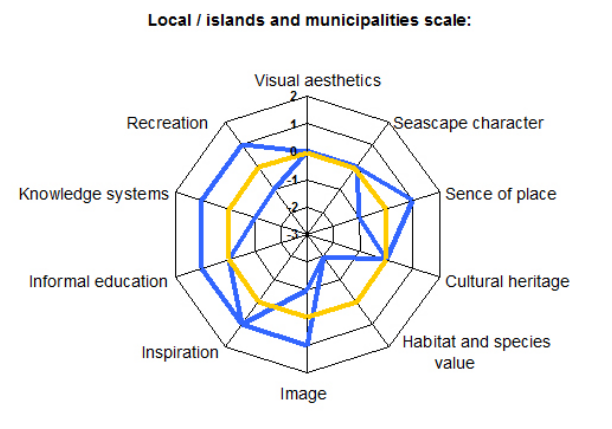
Fig. 5 . Impacts of offshore wind farming on cultural ecosystem services in the case study area (from Busch et al.